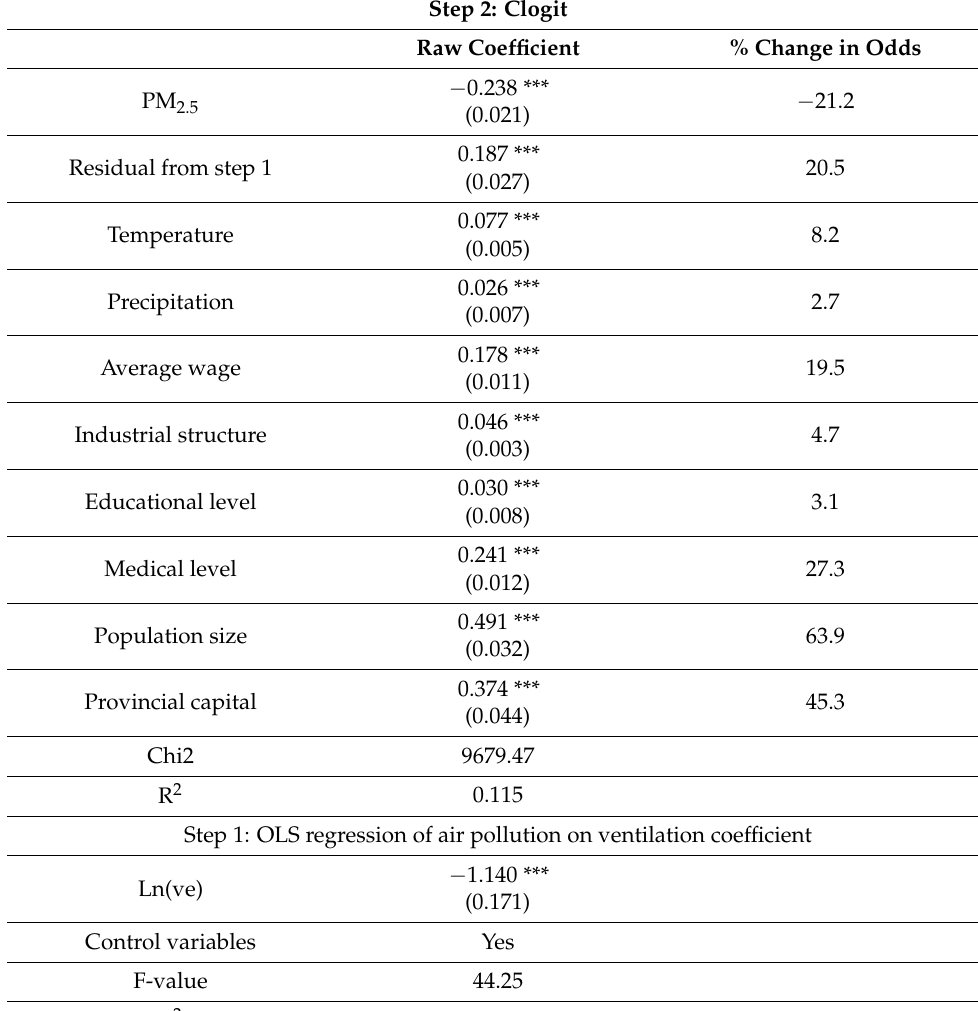
Table 3. Conditional logit regression by using